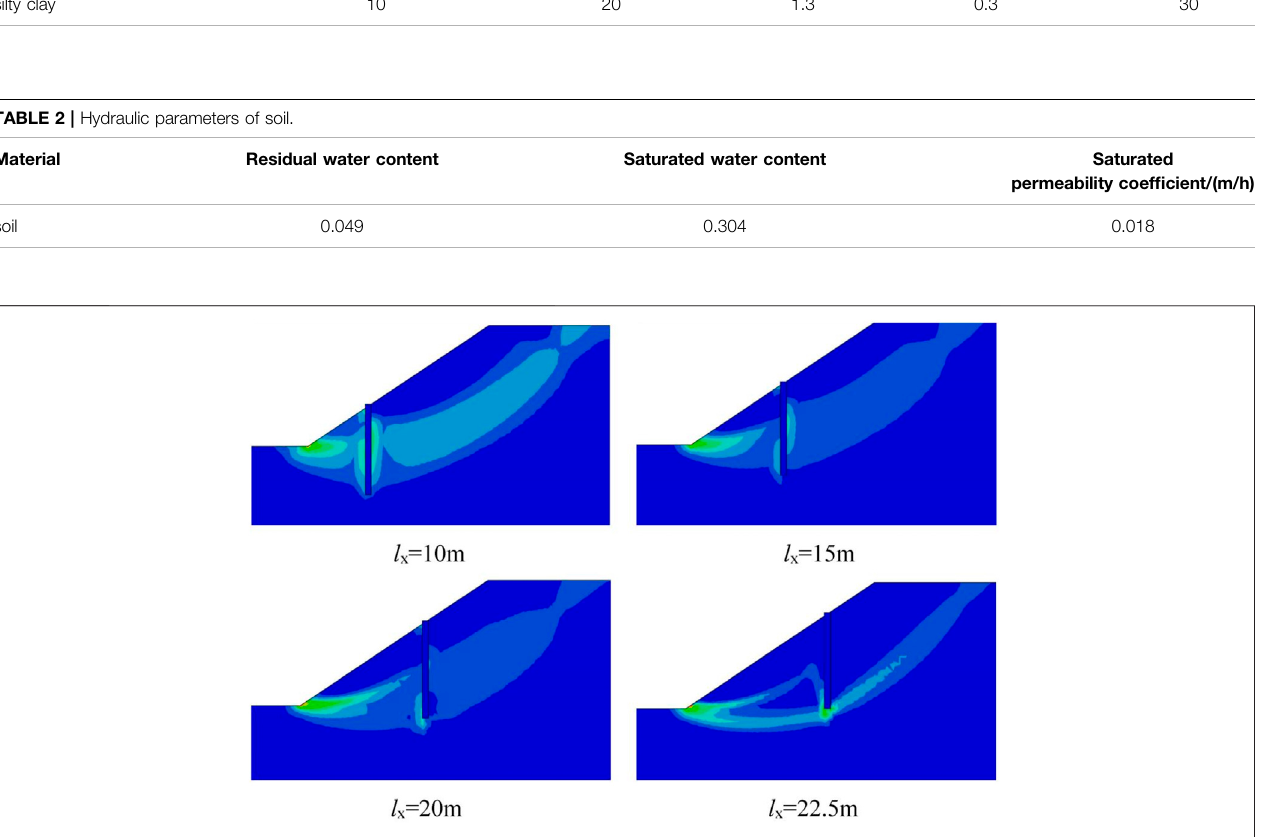
FIGURE 2 | Plastic strain diagram at different pile